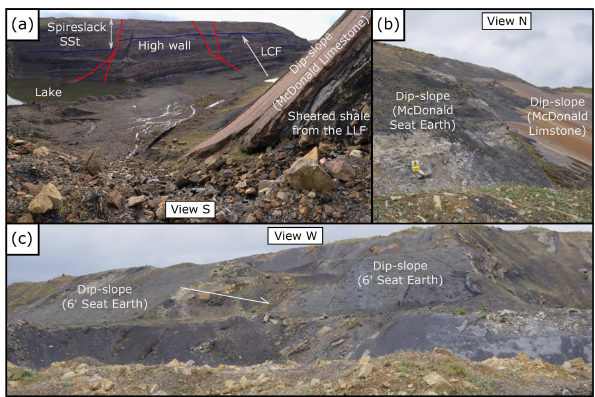
Figure 2. Overview photographs of Spireslack SCM: (a) photo- graph from the east of the site of the high wall with the Mc- Donald Limestone dip slope visible to the right in the foreground (LCF stands for Limestone Coal Formation); (b) photograph look- ing down the McDonald Limestone pavement from the entrance roadway; (c) photograph of the Six Foot Seat Earth exposed in the dip-slope to the west of the